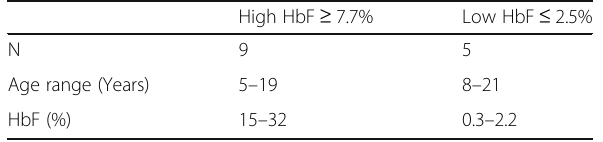
Table 1 Characteristics of Tanzanian individuals sickle cell disease (SCD) with extreme fetal hemoglobin